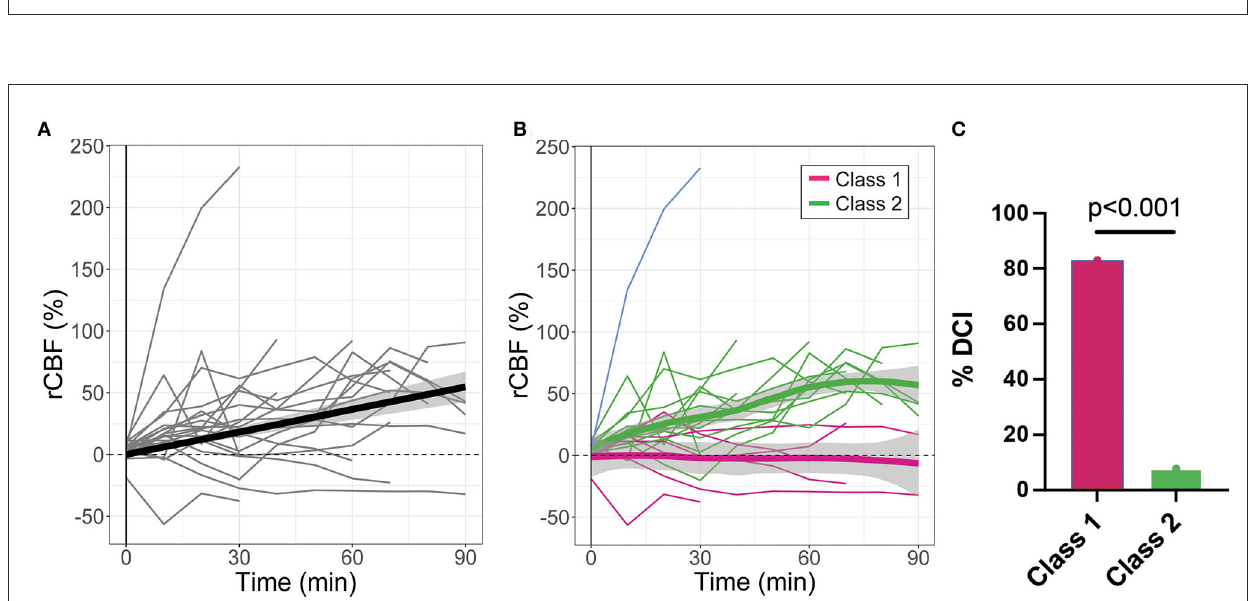
FIGURE3 Relative changes in cerebral blood flow (rCBF) as a function of time post-IT nicardipine administration. (A) Individual patient rCBF trajectories (gray) along with the linear mixed-effects model fit (black). (B) Two distinct latent classes of rCBF response were identified by the latent class mixture model: Class 1 (n = 6, in magenta) showed minimal change in rCBF post-nicardipine, whereas Class 2 (n = 13, in green) exhibited an increase in rCBF over the course of monitoring. The model was overly sensitive to one distinct trajectory (in blue); this outlier trajectory was excluded from analysis. Here, thin lines denote individual patient responses, while thick lines denote the model best fit for each response class. (C) Bar plot of the indicidence of delayed cerebral ischemia (DCI) by rCBF response class.